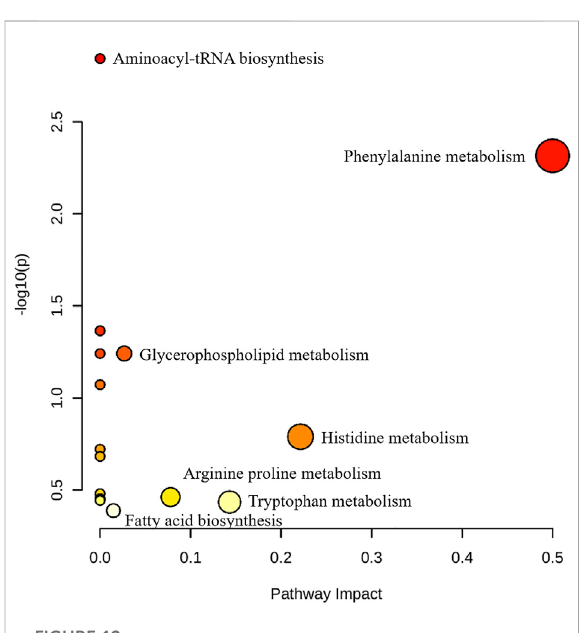
FIGURE 12 Pathway analysis of BMD intervention. The metabolic pathways involved in the protection effects of BMD on MCAO/R